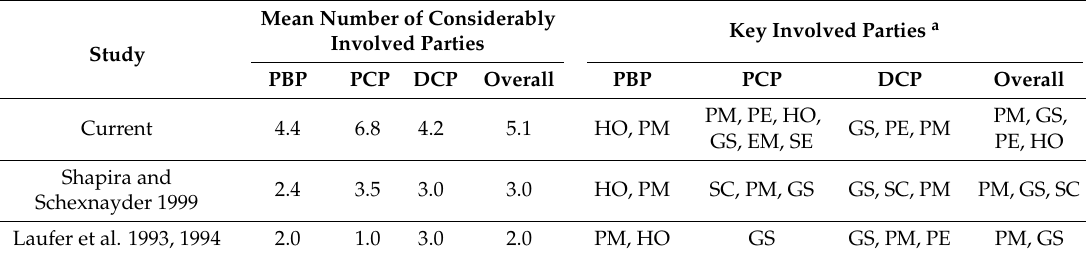
Table 4. Participating